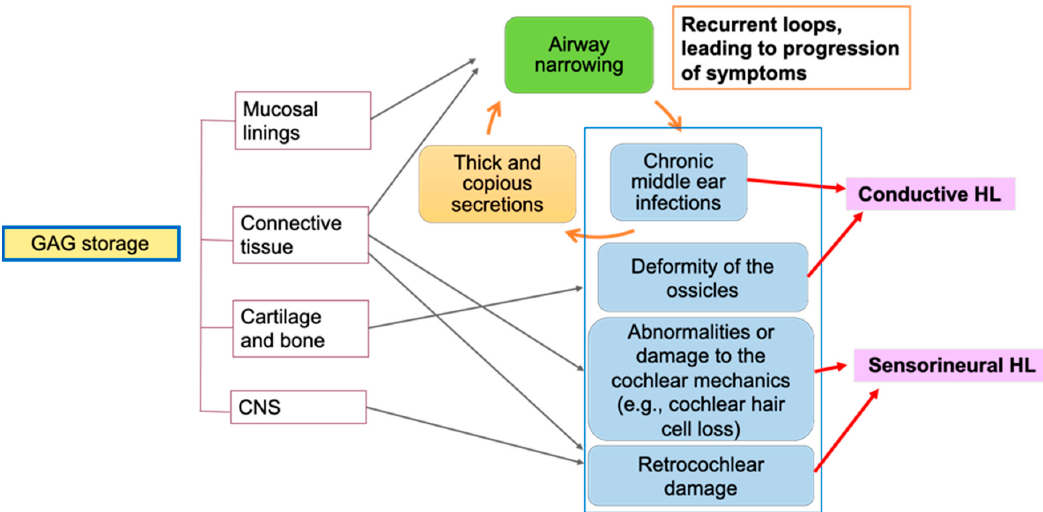
Figure 1. Hearing loss pathophysiology in mucopolysaccharidoses (MPS). GAG, glycosaminoglycan; CNS, central nervous system; HL, hearing loss.